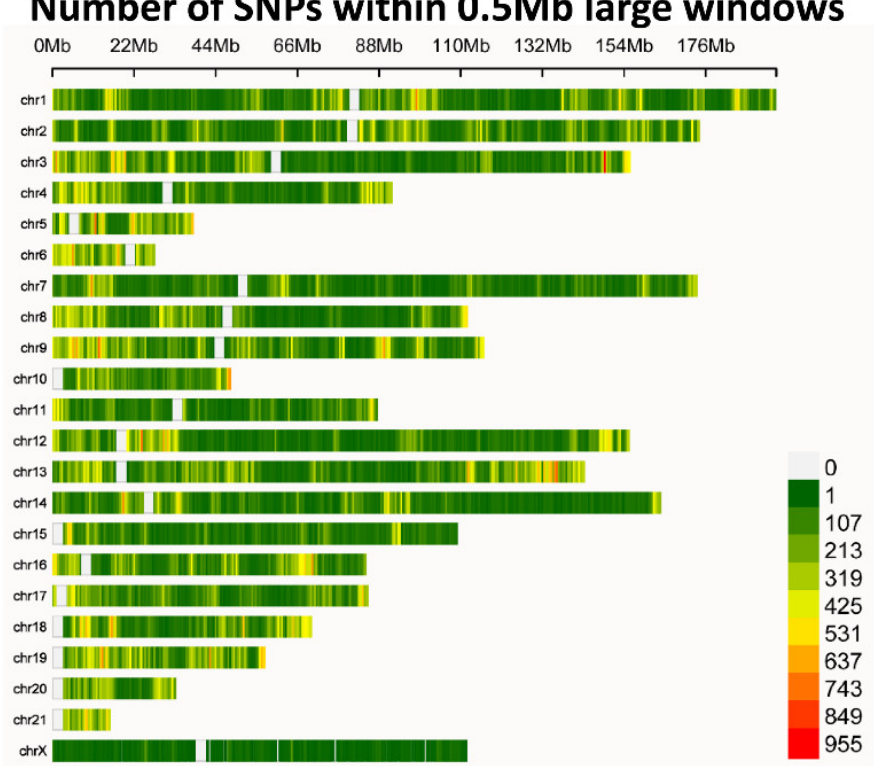
Figure 1. Distribution of SNPs along chromosomes. The vertical axis displays chromosomes (sorted by number) and the horizontal axis represents size of chromosomes. The color bar to the right indicates number of SNPs detected per window.